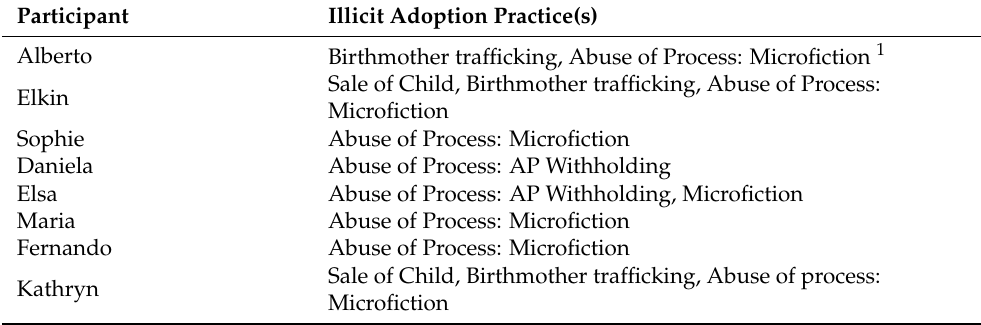
Table 3. Identified Illicit Adoption